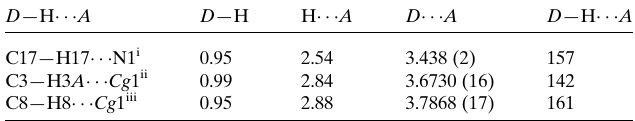
Table 5 Hydrogen-bond geometry (A ˚ , (cid:2) ) for